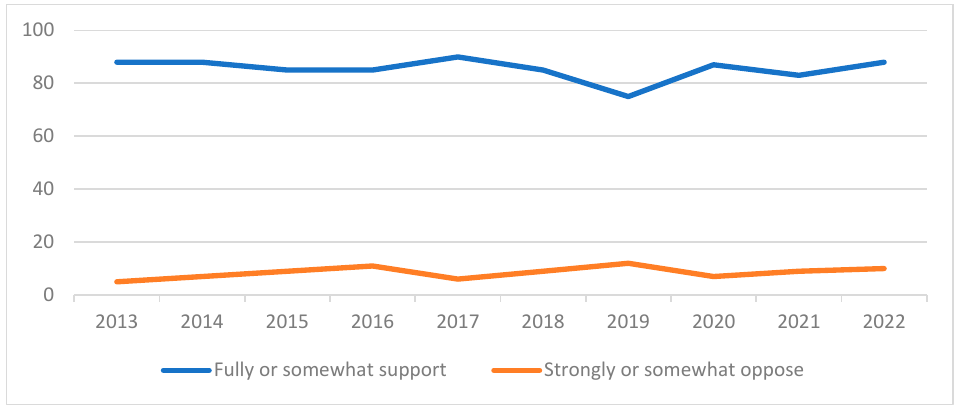
Figure 2. Do you support or oppose Georgia joining the EU? (IRI 2022, p. 68).